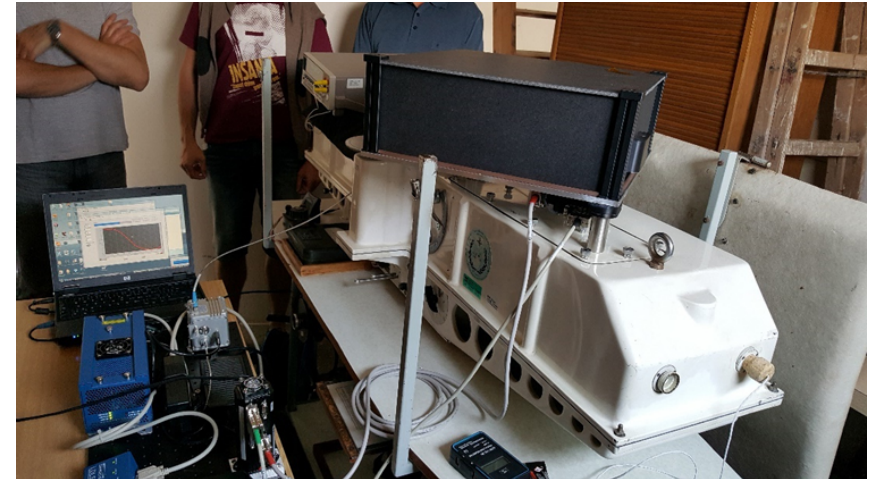
Figure 8. TuPS in-field measurement arrangement (taken during the Dobson calibration in CHMI Hradec Kralove). On the right side – TuPS light engine coupled with the Dobson, in the bottom left corner – driving PC and fibre-coupled discharge UV broadband radiation source.